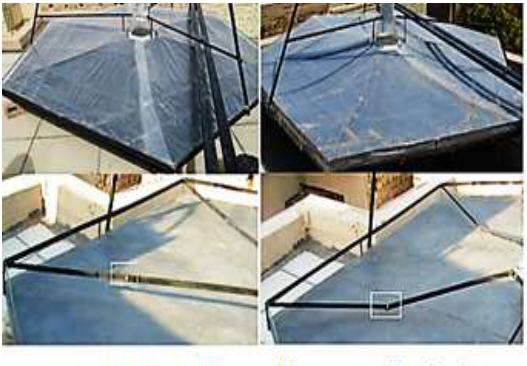
Fig. 7a. The position of reduction